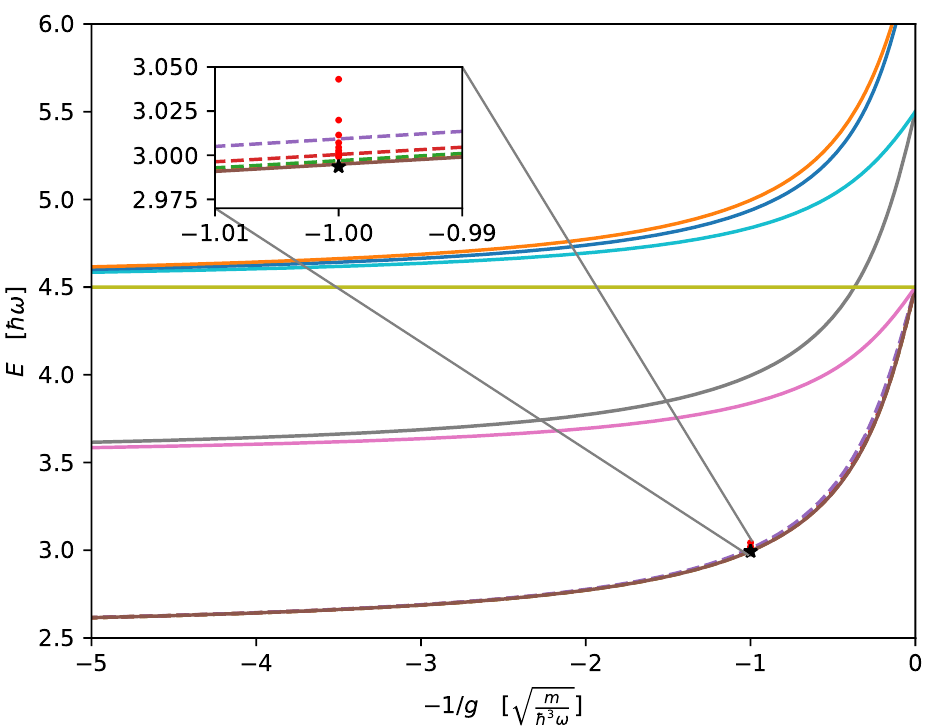
Figure 7: Energies for the lowest seven states for the 2 + 1 system computed using the variational method. The result using the matrix product states method for increasing accuracy is shown in red dots, with the black star being the extrapolated value. The energies are computed using basis states with basis threshold 8. The ground state is computed also using basis threshold 0, 2, 4 and 6 to show the convergence, which are shown with dashed